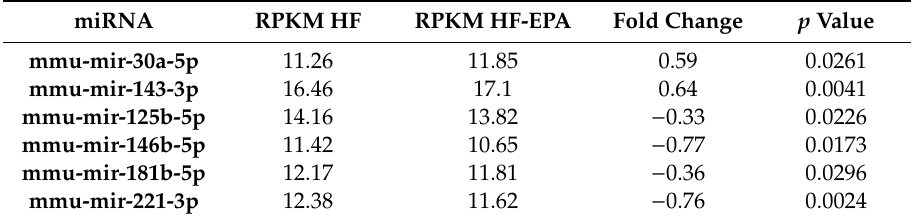
Figure 3. Validation miRNAs in adipose tissue of obese B6 mice using qPCR. The miRNA expression levels were validated. Validation of miR-30a-5p, miR-143-3p, miR-125b-5p, miR-146b-5p, miR-181b-5p, miR-221-3p; data are expressed as mean ± SEM, * p ≤ 0.05, n = 6; HF vs. HF-EPA. Red = upregulated; green = downregulated. Table 4. Di ff erentially expressed microRNAs modulated by EPA in visceral adipose tissue of B6 obese mice. FDR-adjusted p value ≤ 0.05, log2 fold change >